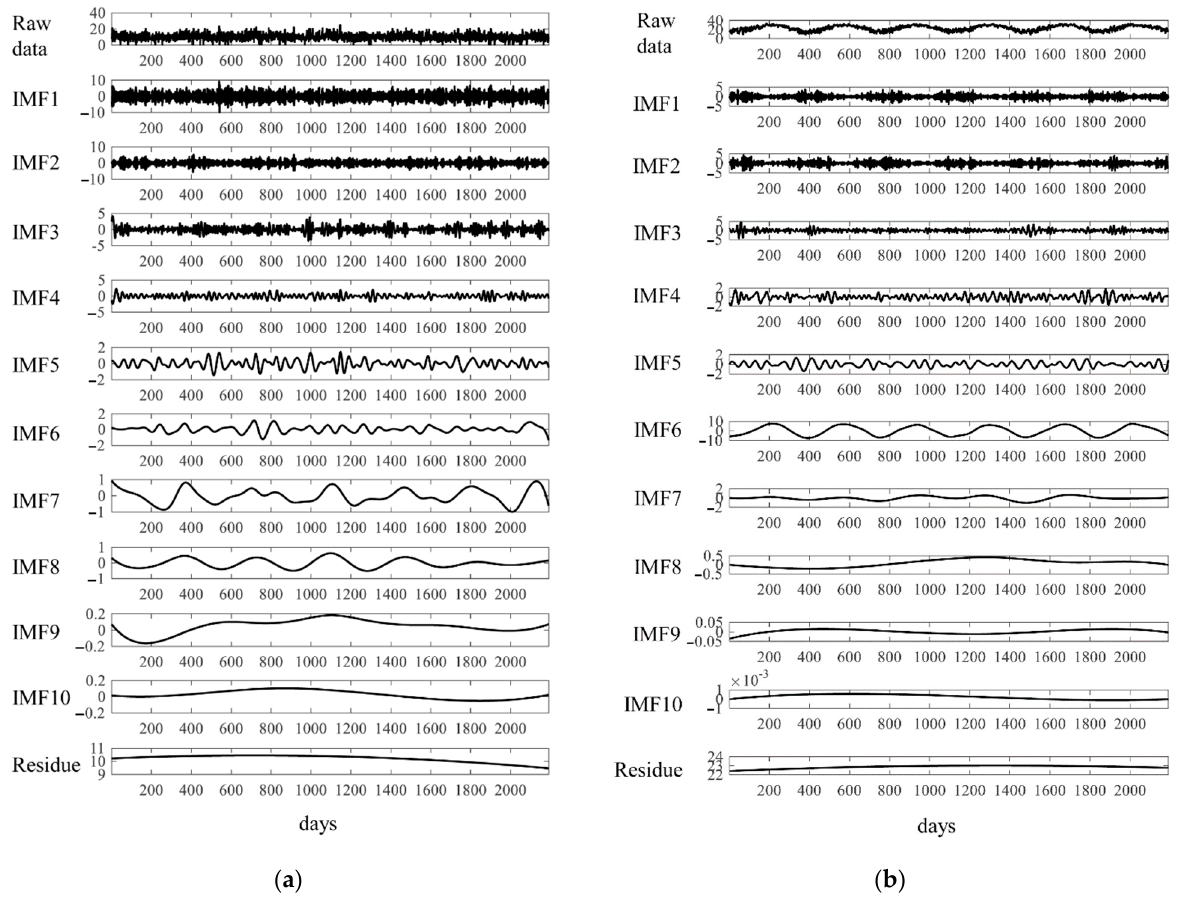
Figure 3. Intrinsic mode functions (IMFs) of decomposed daily mean temperatures ( a ) and events of intracerebral hemor- rhage in the elderly group ( b ) in Taipei Area.